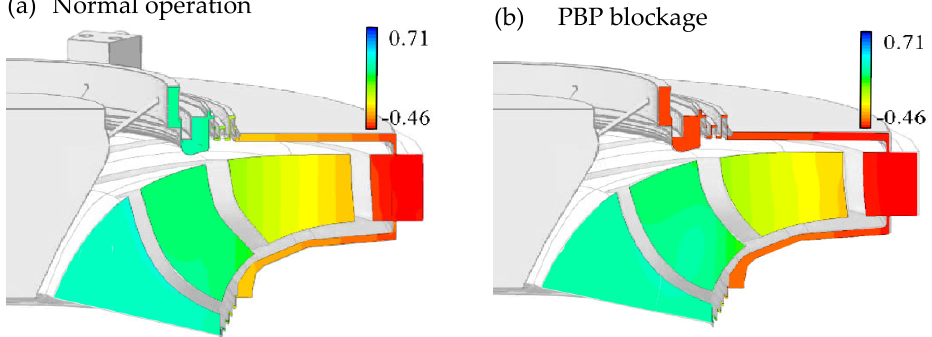
Figure 15. Comparison of pressure distribution between ( a ) normal condition and ( b ) PBP blockage condition at C φ = 0.032.